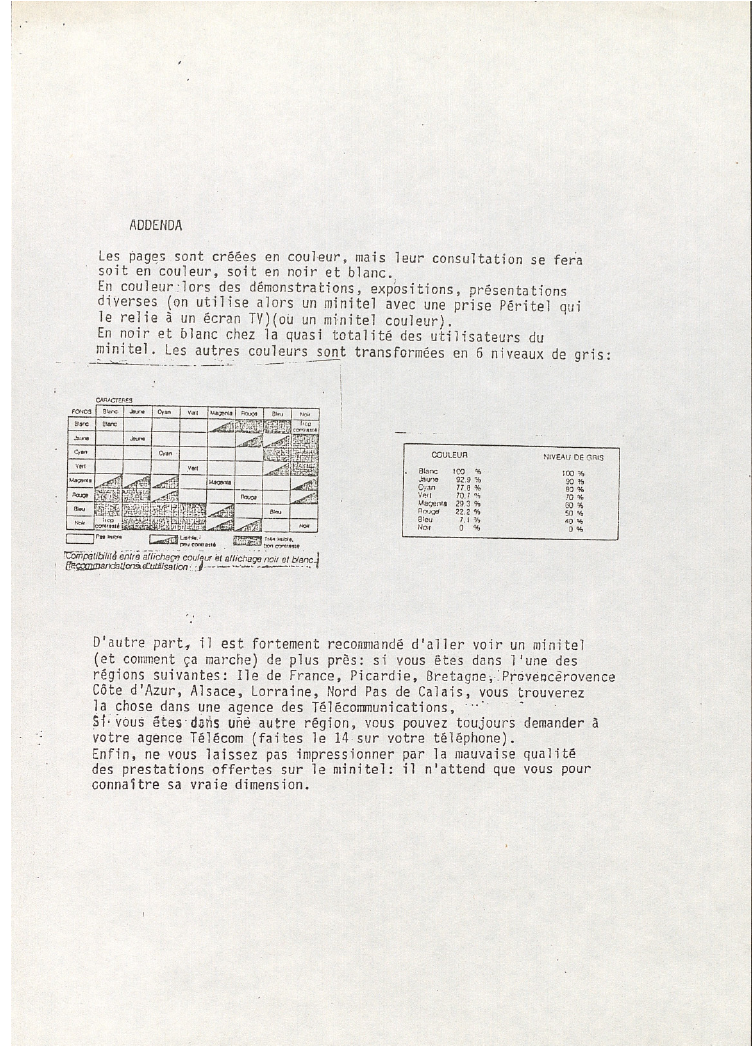
Figure 2. Document with instructions sent to each artist participating in Art Accès . Collection Frédéric Develay © Kandinsky Library, MNAM/CCI, Centre Pompidou.